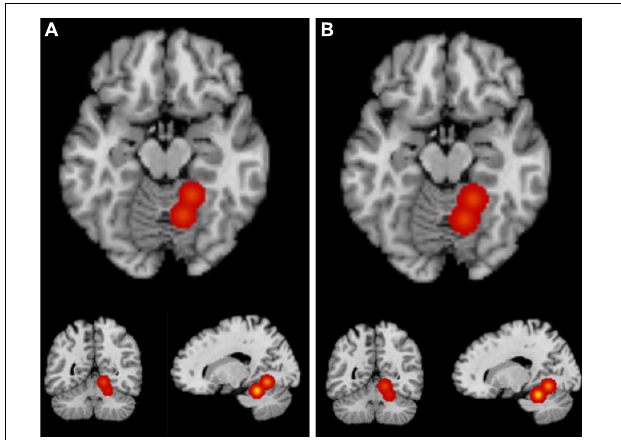
FIGURE 1 | ALE Results. ALE maps from the bilinguals > monolinguals analyses for Analysis 1 (A) and Analysis 2 (B) at a voxel-wise threshold of p < 0.001 and an FWE cluster correction at p < 0.05 with 1,000 permutations. Both analyses identified one cluster primarily located in the right culmen within the anterior cerebellum. See Table 3 for cluster